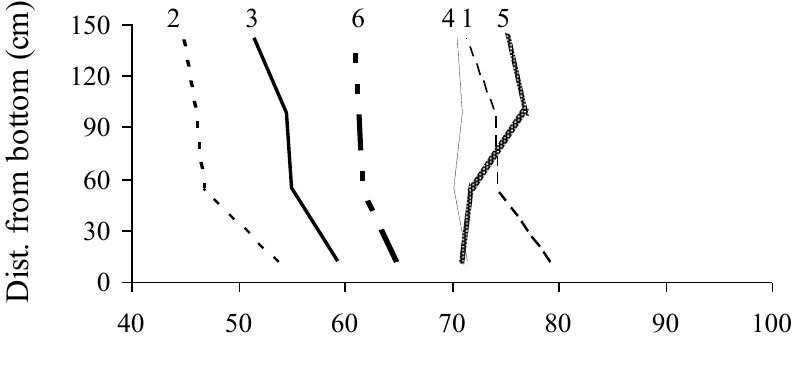
Figure 7. Distribution of in-place compressive strength at 56 days determined from core samples along experimental wall